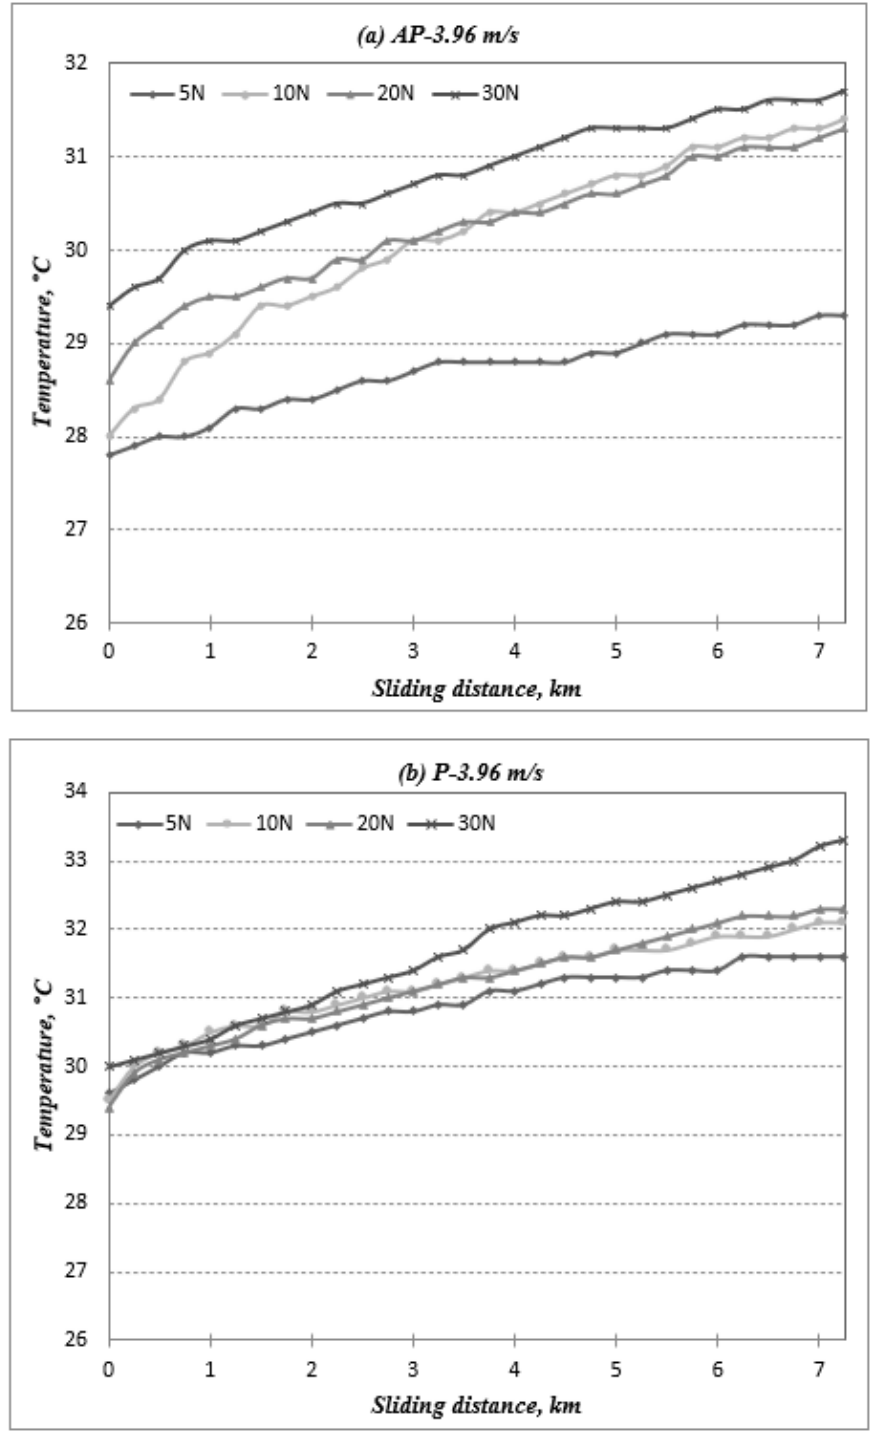
Figure A6. Temperature vs. sliding distance for AP and P fibre orientation subjected to different applied normal loads at 3.96 m/s counterface sliding velocity .